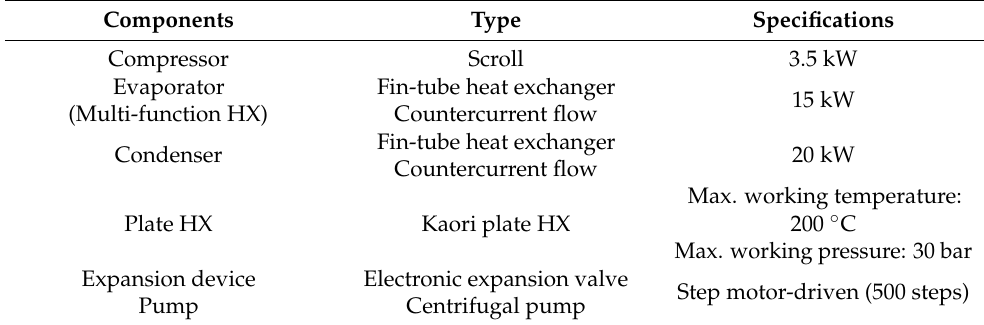
Table 1. Specification of both conventional and hybrid test unit.